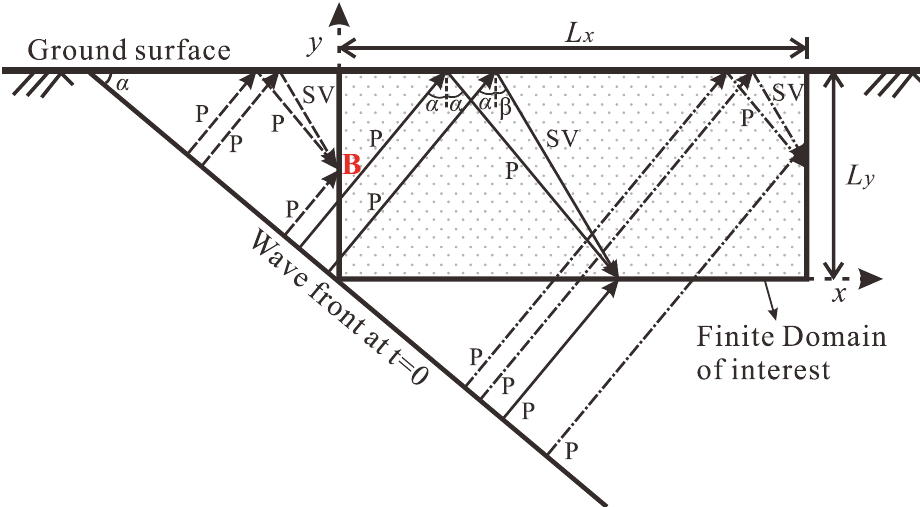
Figure 4. Sketch of the seismic waves on truncated boundary by obliquely incident P waves.